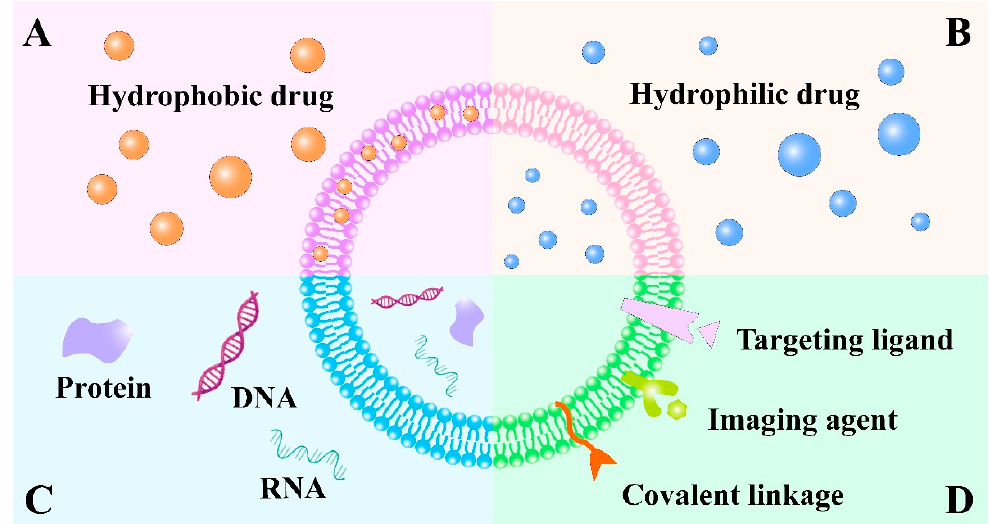
Figure 7. Schematic illustration of various types of exosome-based drug delivery systems. Exosomes are composed of a lipid bilayer that consists of lipids to enclose an aqueous core. Both the lipid bilayer and the aqueous core can incorporate ( A ) hydrophobic drugs and ( B ) hydrophilic drugs. ( C ) Exosomes can be used to deliver macromolecules such as DNA, RNA and protein. ( D ) Theranostic or imaging probes, specific targeting ligands and covalent linkage can also be attached to exosome surface for biomedical application.